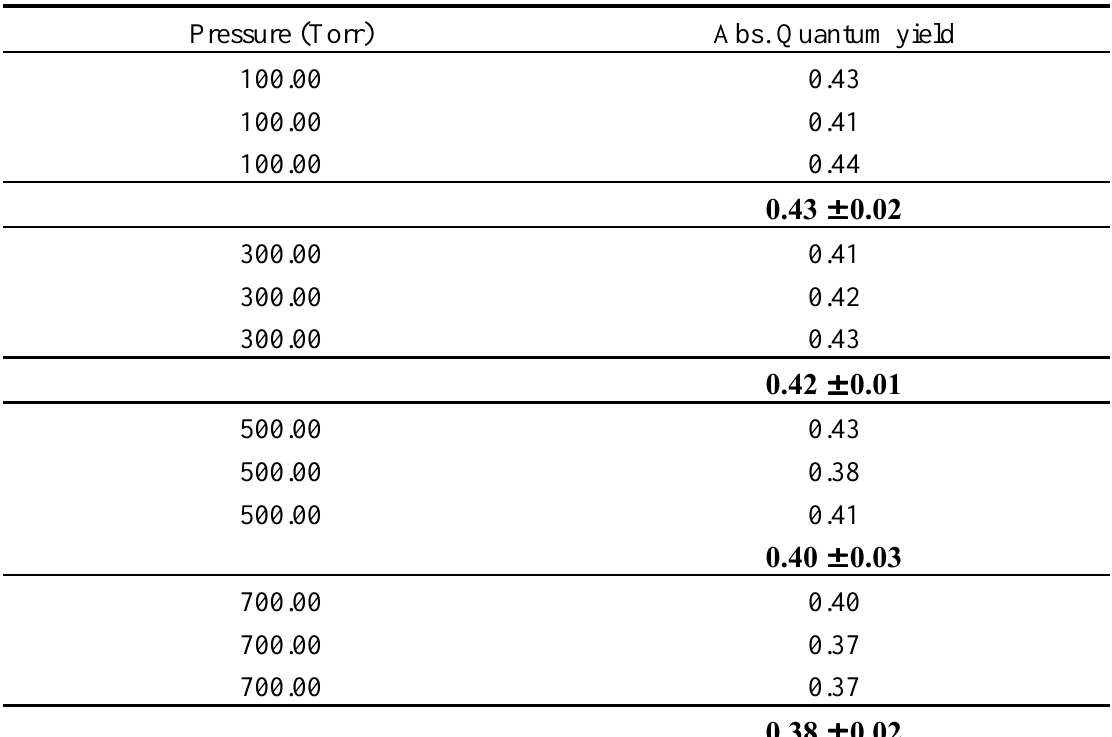
Table 3. Absolute quantum yield values n -hexanal photolysis at different pressures of synthetic air (errors are represented by experimental